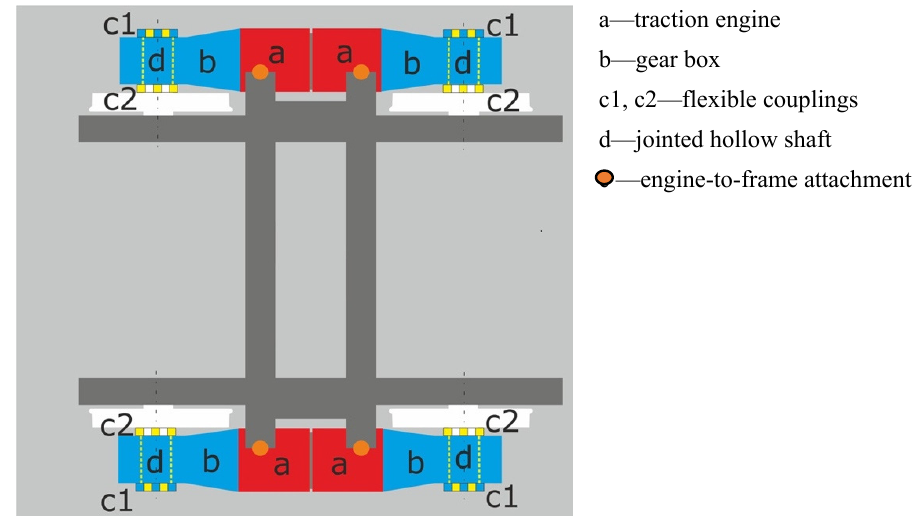
Figure 6. Drive system with individual wheel drive, where one motor drives one wheel, source: